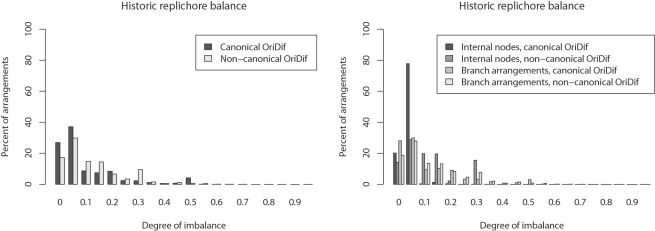
Association between replichore balance and the relative orientation of ori and dif.Left: Balance for canonical and non-canonical OriDif configurations. Right: Balance as a function of whether arrangements are at an internal node or along a branch. Arrangements at internal nodes of the phylogeny appear to be better balanced, but only when ori and dif are in the canonical orientation.